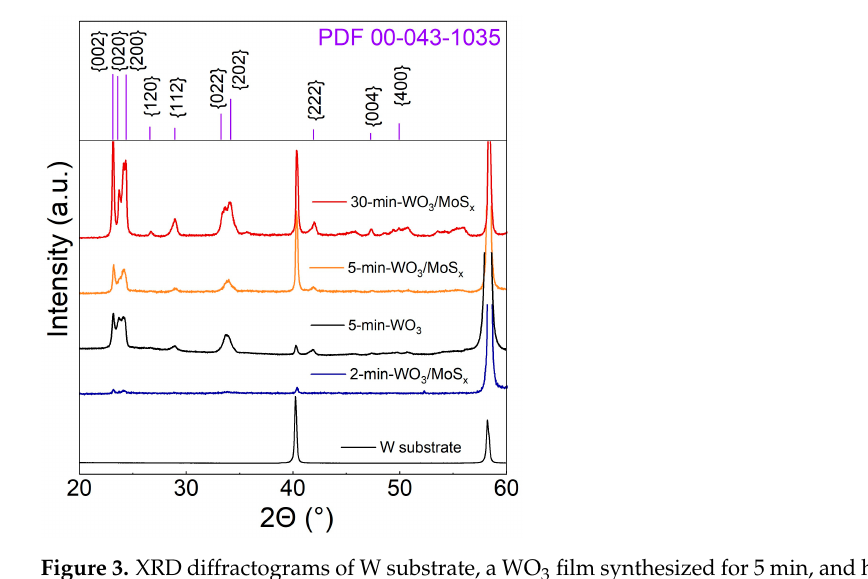
Figure 3. XRD di ff ractograms of W substrate, a WO 3 fi lm synthesized for 5 min, and heterostruc- Figure 3. XRD diffractograms of W substrate, a WO 3 film synthesized for 5 min, and heterostructured tured fi lms, synthesized for 2, 5, and 30 min. films, synthesized for 2, 5, and 30 min.